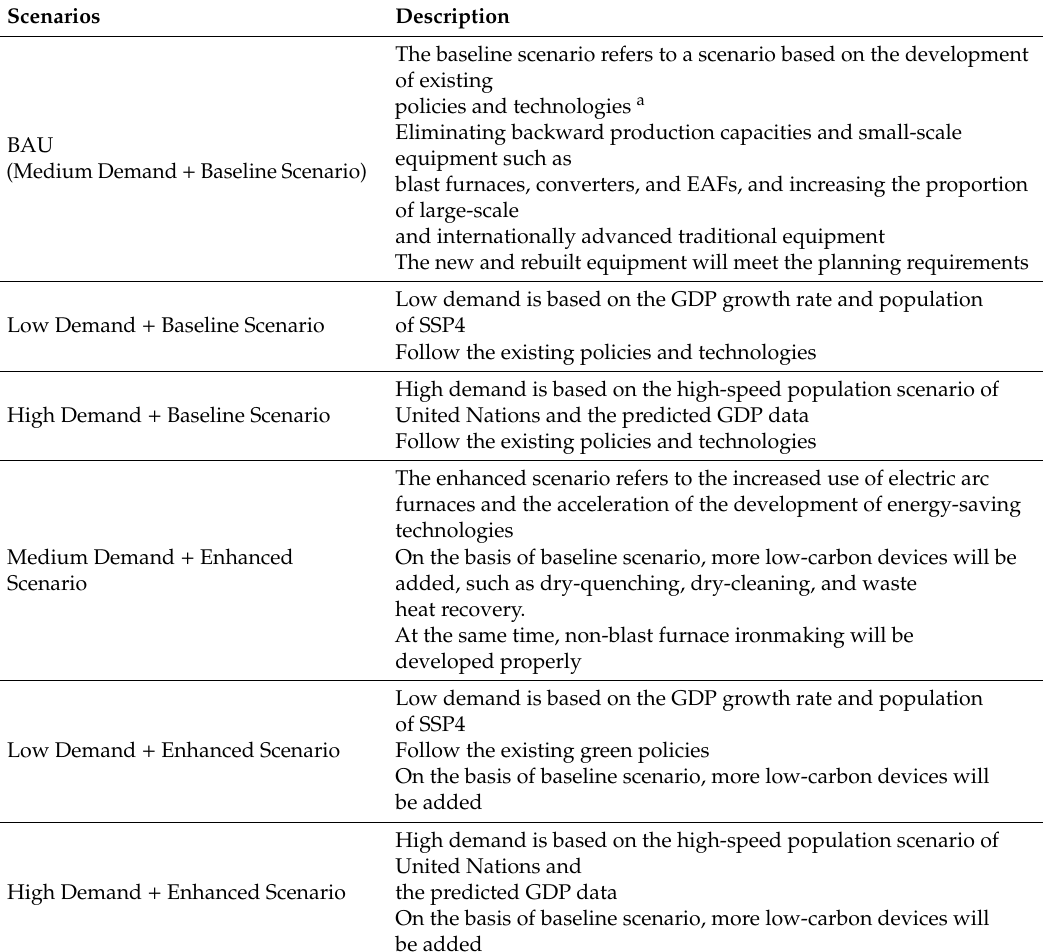
Table 4. Scenario descriptions in the steel